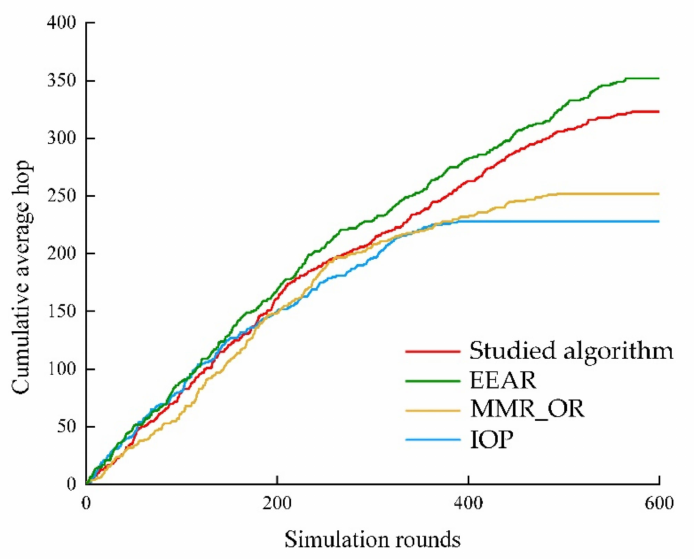
Figure 9. Comparison of the emergency data transmission